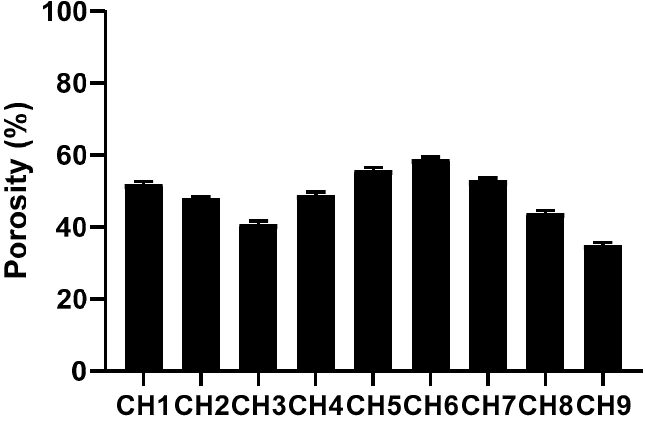
Figure 6. Porosity (%) of BSG-co-poly (AA)-loaded hydrogel.